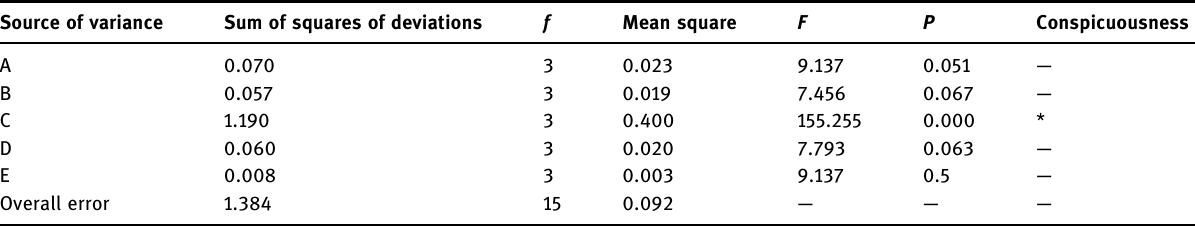
Table 7: Variance analysis of the kerf width Source of